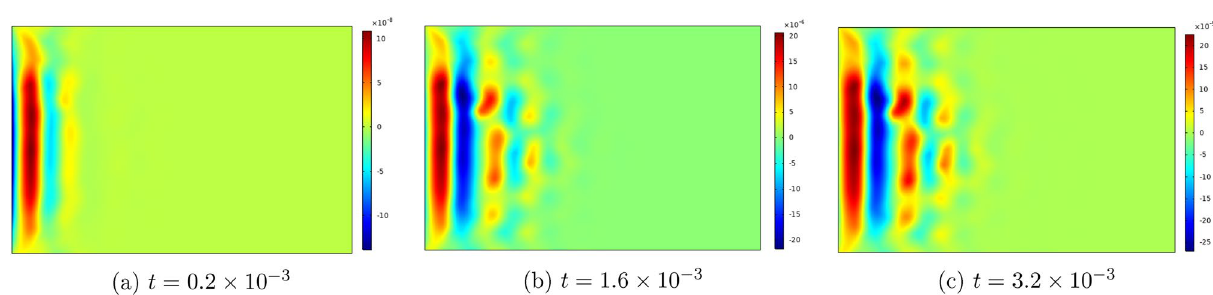
Figure 8. Top view of the distribution of u x in the slab at three consecutive time moments.